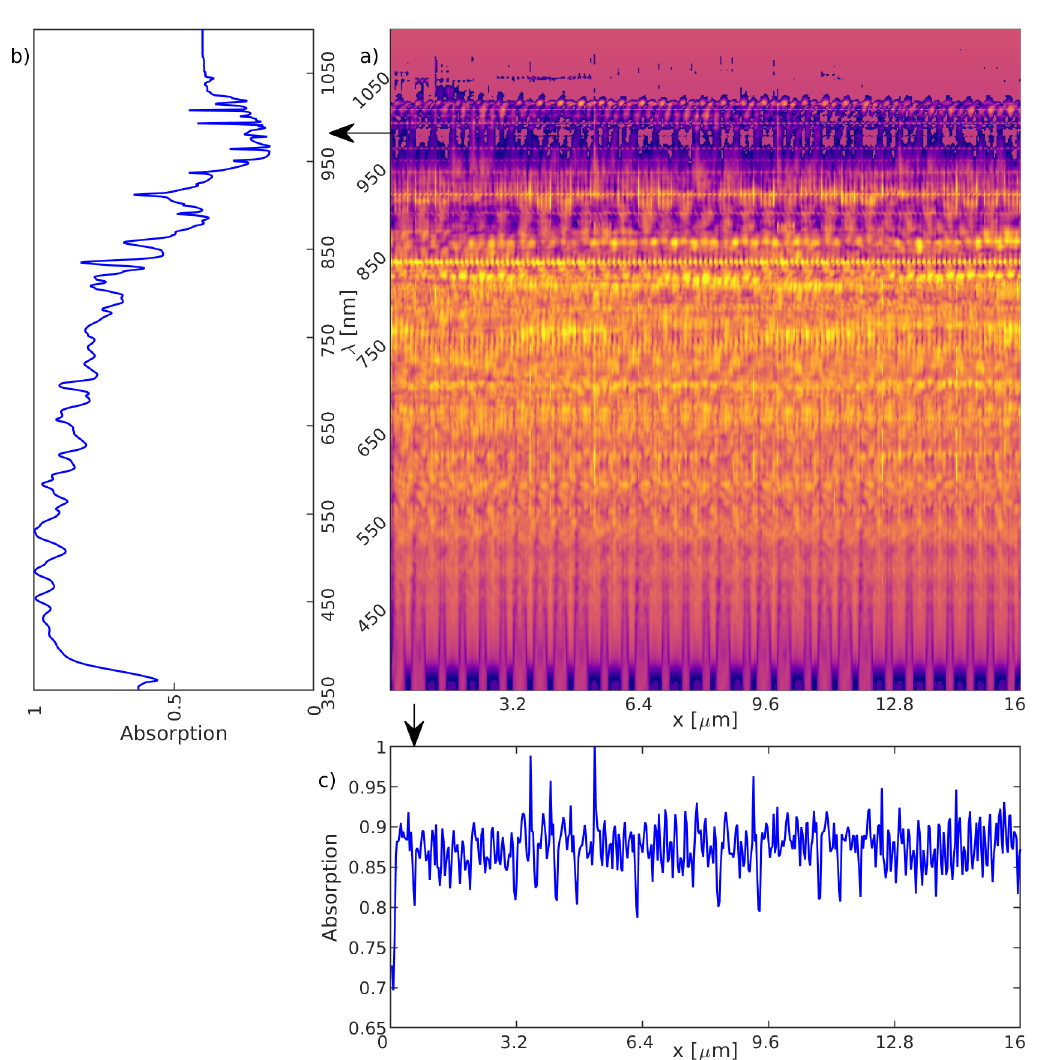
Figure 13. ( a ) the spatio-spectral absorption density map as a comprehensive display of the active layer’s optical absorption as a function of both, the horizontal active layer position and the operating wavelength. It should be mentioned that bright colors refer to high values and cold colors to lower values; ( b ) spectral response of the overall absorption (i.e., spatial integration of the map); ( c ) spatial distribution of the overall absorption along the grating structure (i.e., spectral integration of the